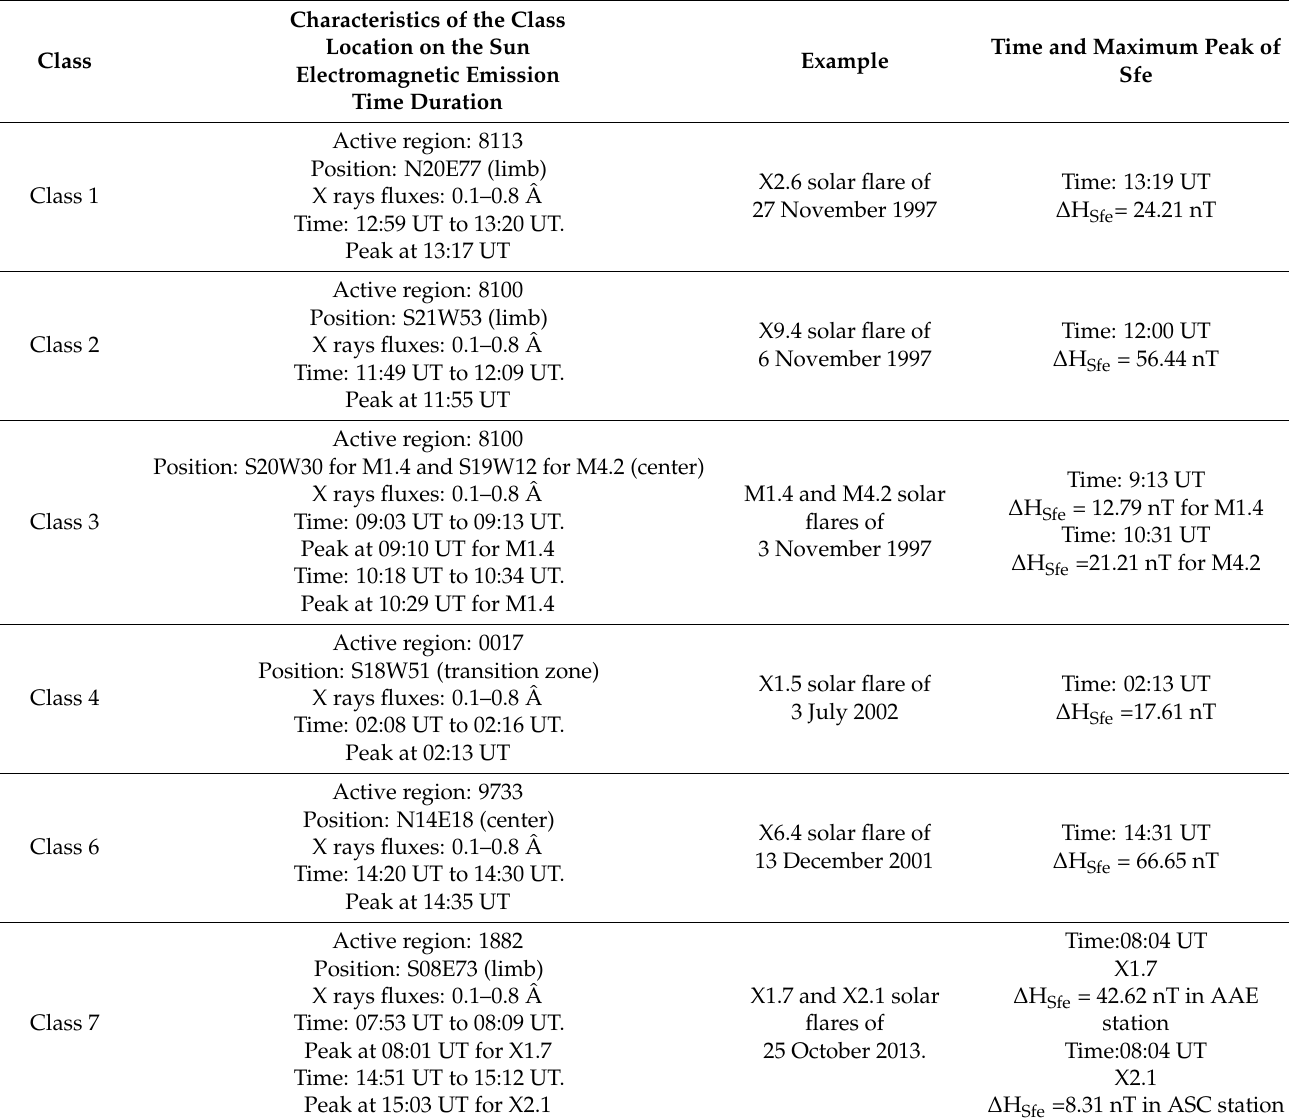
Table 8. Summary synthesis of all class